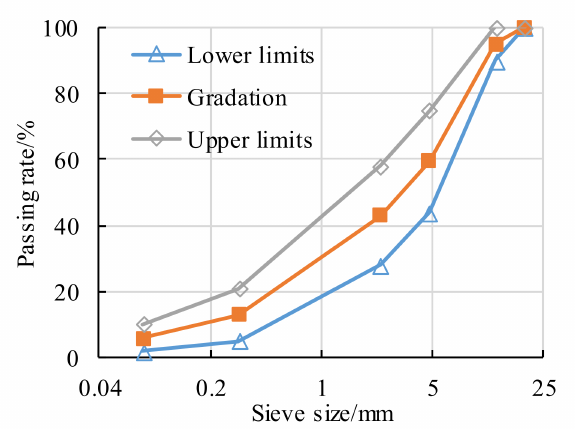
Figure 2. Size gradation of